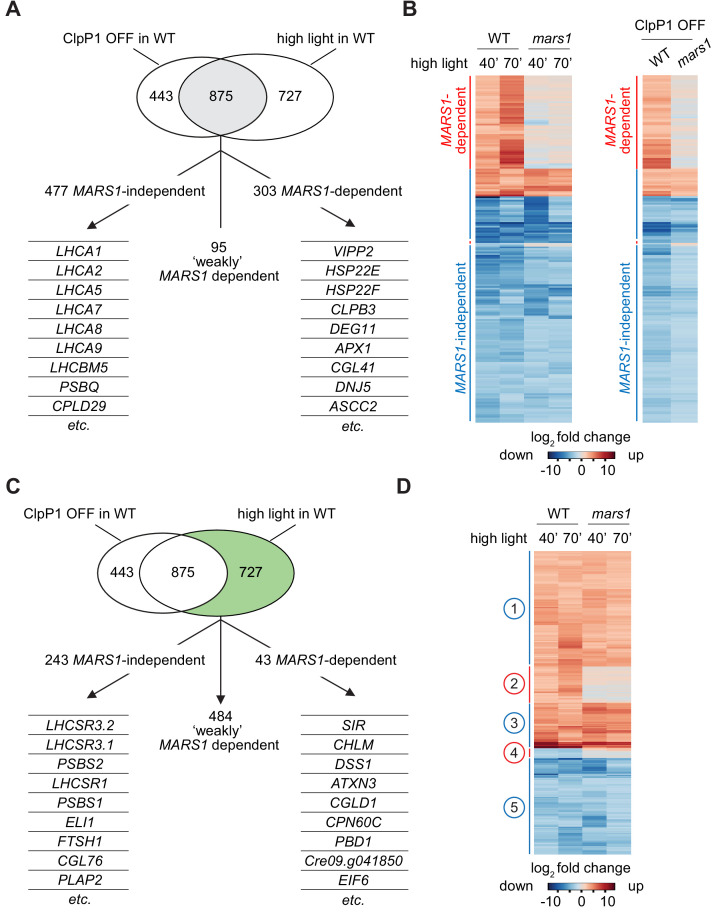
mars1 cells do not activate the cpUPR transcriptional program.(A) Venn diagram highlighting the transcriptional changes elicited genetically (ClpP1 repression) or physiologically (HL exposure) in Chlamydomonas cells , as determined by RNA sequencing (overlap in gray). The 875 common stress-responsive genes are defined as genes whose expression showed at least a 4-fold change upon stress (p<0.001) and were consistently up- or down-regulated in both high light and ClpP1 repression. These genes are further subdivided in three groups: 1) MARS1-dependent, being unresponsive (<2-fold change) when MARS1 was disrupted; 2) ‘weakly’ MARS1 dependent, being only mildly induced or inhibited (<4-fold but >2-fold) upon stress in the mars1 background; and 3) MARS1-independent, being still responsive (<2-fold change) in absence of MARS1 expression. A short list of genes belonging to each category (MARS1-dependent and MARS1-independent) is provided. Full lists of MARS1-dependent and MARS1-independent genes are available through Figshare (https://figshare.com/s/992706a610ce6b71f03c and https://figshare.com/s/66417c2b28f3110b8077). (B) Heat-map comparing gene expression patterns of the 875 common stress-responsive genes (as defined in Figure 5A) in WT and mars1 cells upon exposure to HL (for 40 or 70 min) or in ClpP1-nonpermissive conditions (+Vit). (C) The same Venn diagram shown in Figure 5A highlighting (in green) genes that are preferentially responsive to HL exposure (>4-fold change only upon HL stress, p<0.001, and consistently up- or down-regulated in both time points during HL stress). These 727 genes are further categorized based on their gene expression dependency on MARS1. A short list of genes belonging to each category (MARS1-dependent and MARS1-independent) is provided. MARS1-dependent genes are related to chloroplast protein folding and degradation, protein translation or are poorly characterized. By contrast, the list of MARS1-independent genes includes key regulators of nonphotochemical quenching such as LHCSR and PSBS genes. HL = high light; ClpP1 OFF = ClpP1 repression. (D) Heatmap showing genes that are preferentially responsive to HL exposure. Five clusters of genes are highlighted on the side. Numbers circled in blue and red indicate gene clusters not affected and affected by MARS1 disruption, respectively.